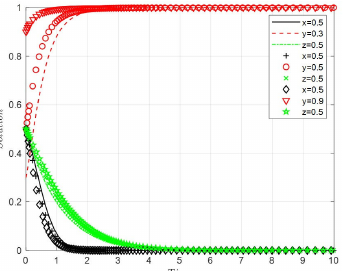
Figure 2. The evolutionary path of scenario 2.